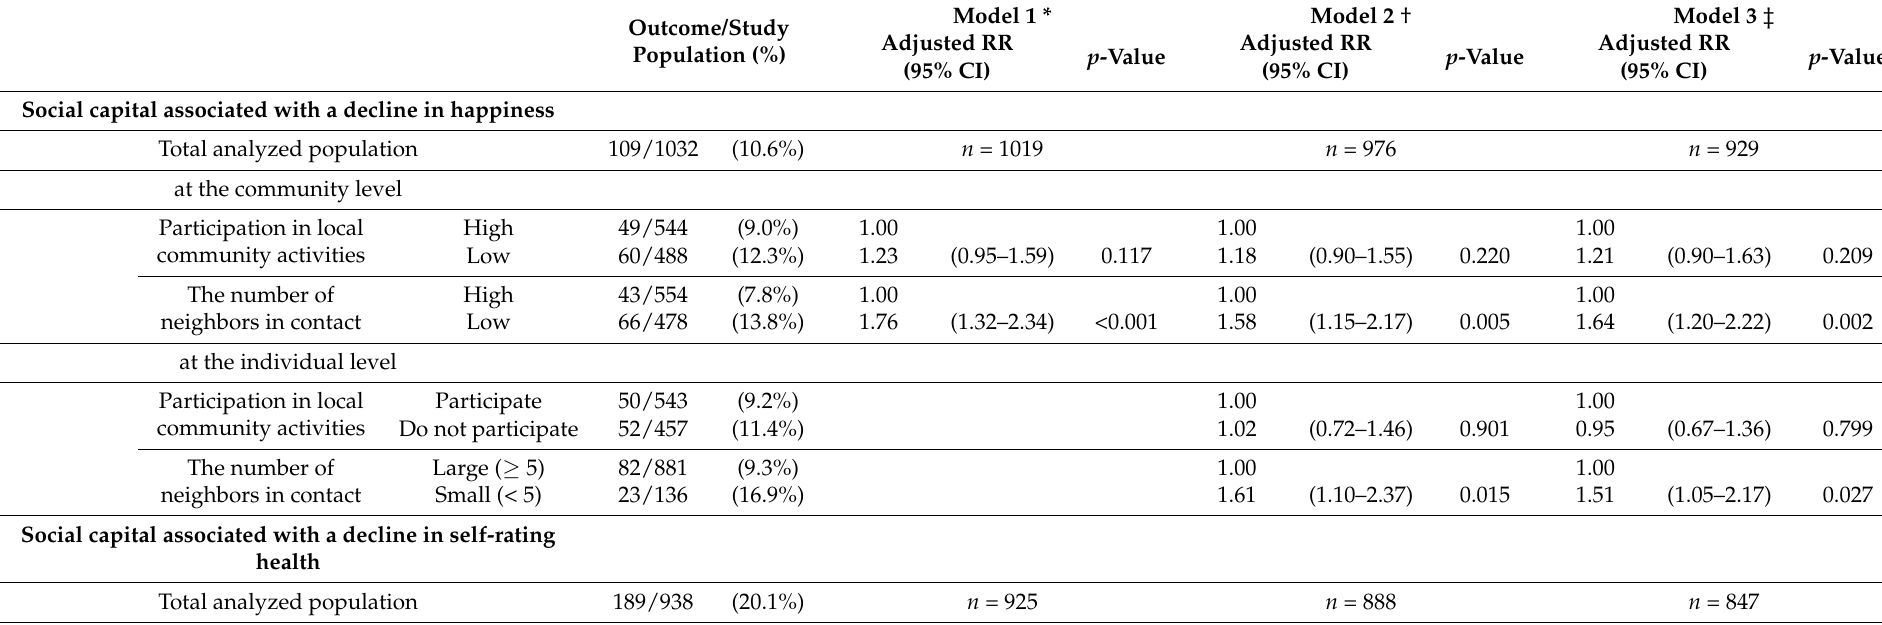
Table 2. The association of social capital at the community and individual levels with a decline in well-being: results from multilevel Poisson regression